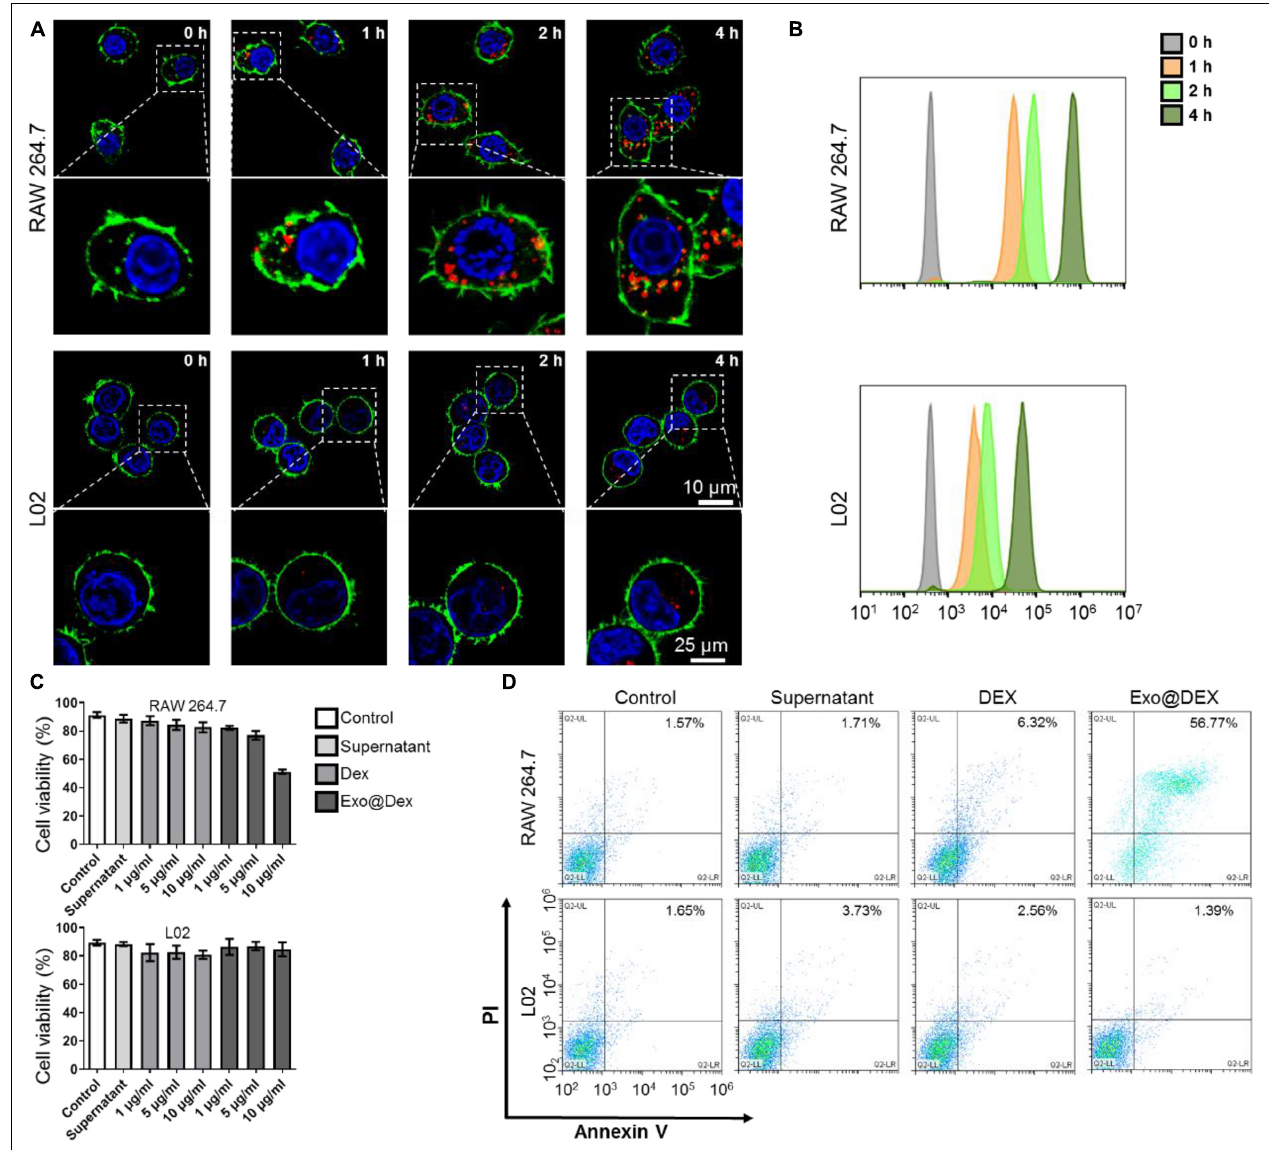
FIGURE 2 | Cellular internalization of Exo@DEX and its effect on macrophage in vitro . (A) Representative fluorescence images of Exo uptake by RAW264.7 macrophages and L02 liver cells in vitro in a time-dependent way (images were enlarged, indicated by a white dotted box). Nuclei were stained with DAPI (blue), the cell membrane was stained with phalloidin (green), and Exo@DEX was stained with DiD (red). (B) Flow cytometry assay of RAW264.7 and L02 cells incubated with DiD-labeled Exo@DEX. (C) CCK-8 analysis of RAW264.7 and L02 cells. Cells were incubated with Exo-free supernatant (Supernatant), non-exosomal DEX, or exosomal DEX (Exo@DEX) for 24 h. (D) Flow cytometry analysis of annexin V-and-PI staining of RAW264.7 and L02 cells incubated with Supernatant, DEX, or